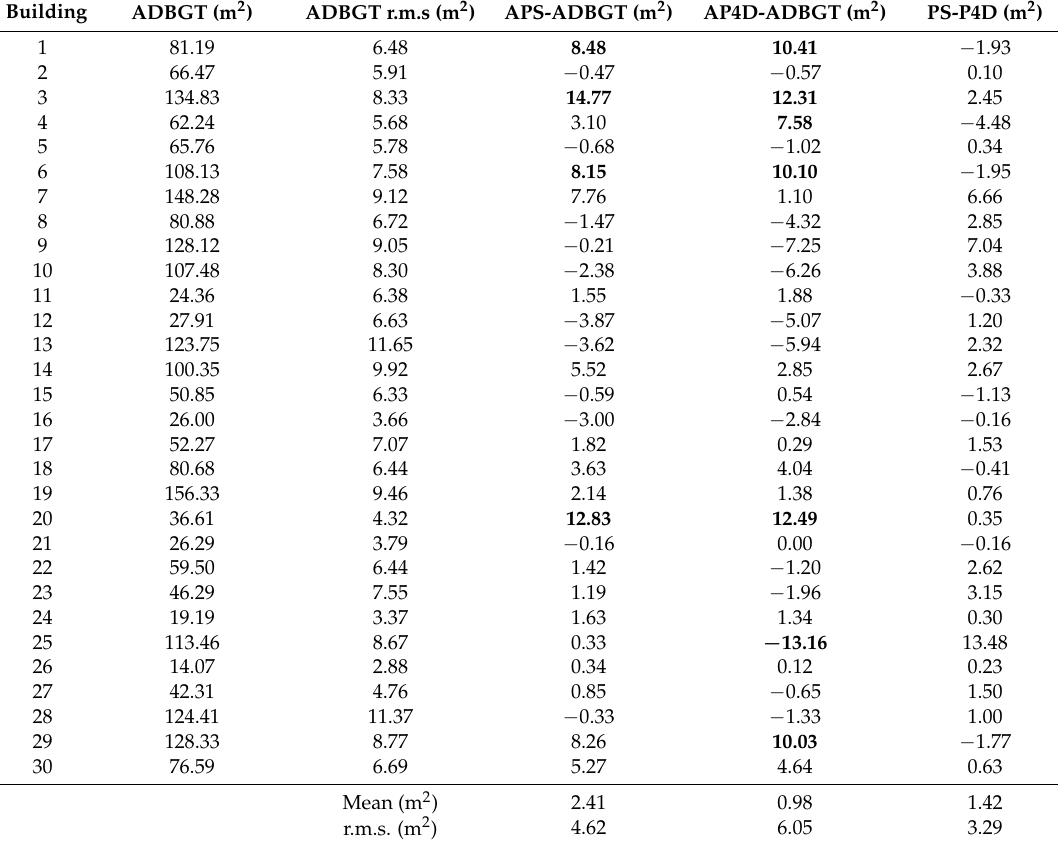
Table 6. Results of the area